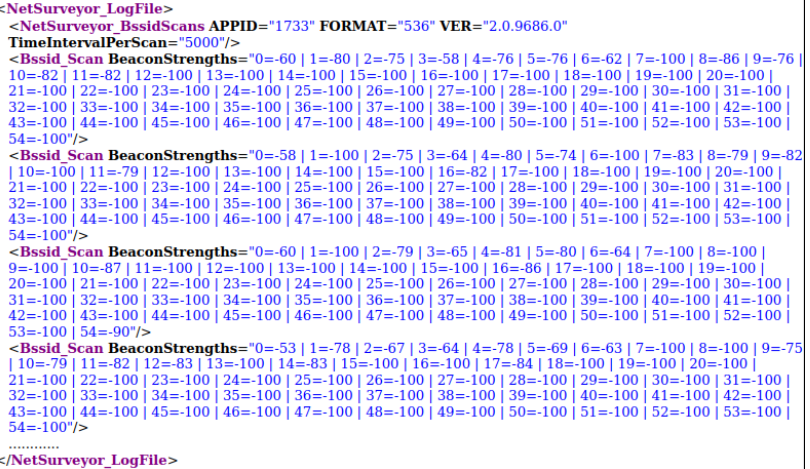
Figure 2. The recorded RSS Indicator data as XML